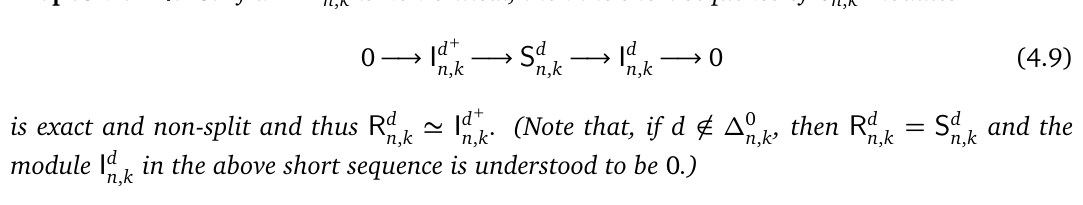
with (cid:96) = 5, s = 7 and t = 4,3